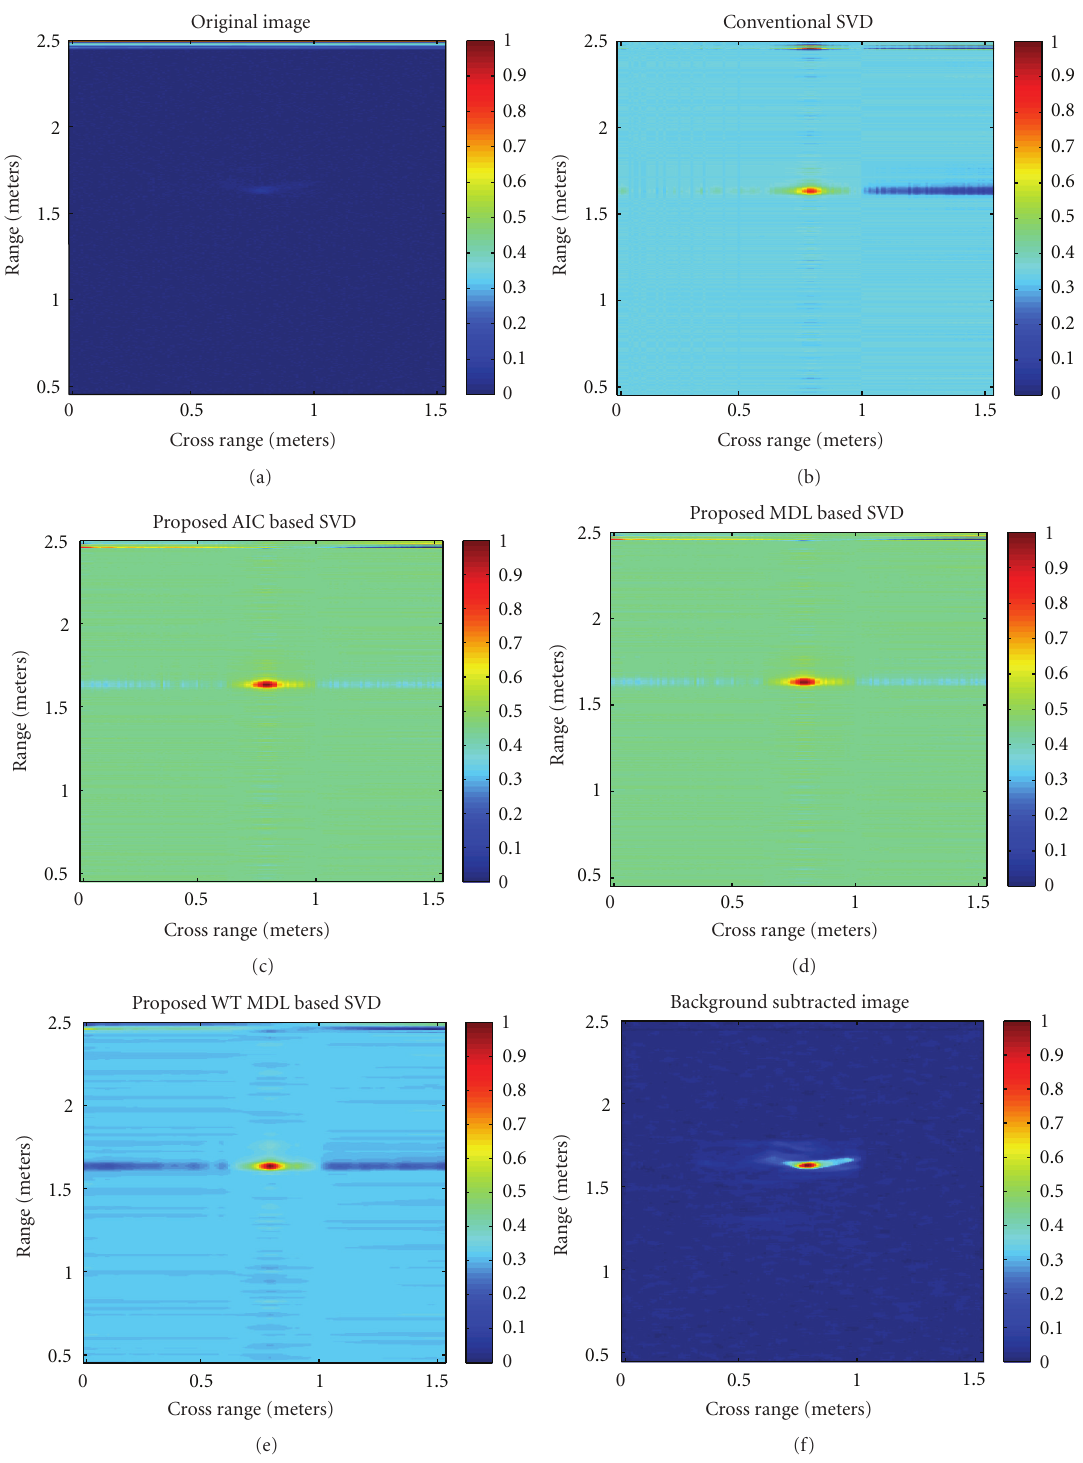
Figure 9: Example 1: Single target (a) original image, (b) conventional SVD, (c) AIC-based SVD, (d) MDL-based SVD, (e) WT MDL-based SVD, and (f) background subtracted